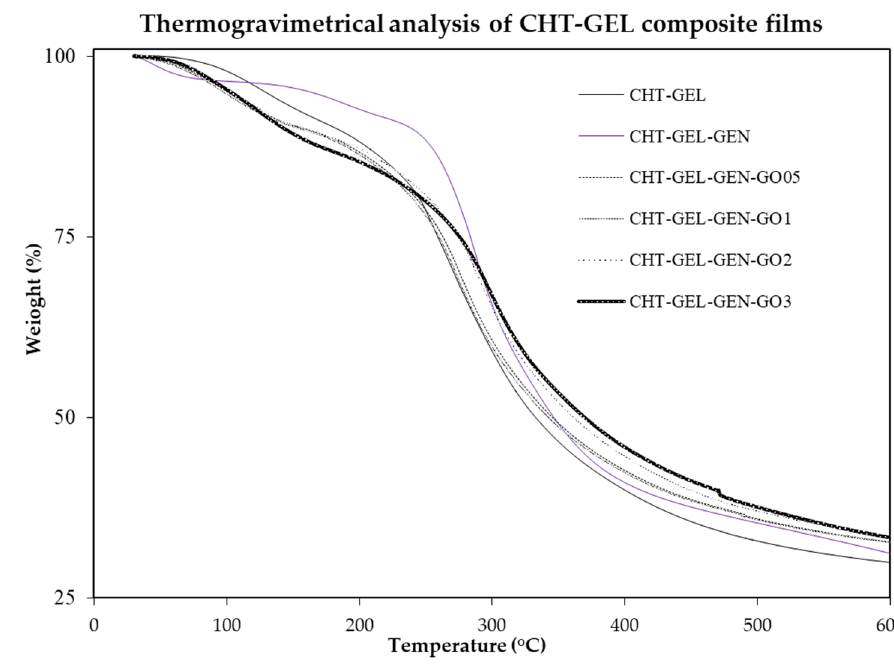
Figure 3. TGA curves obtained for the biopolymer–GO composite films and control.